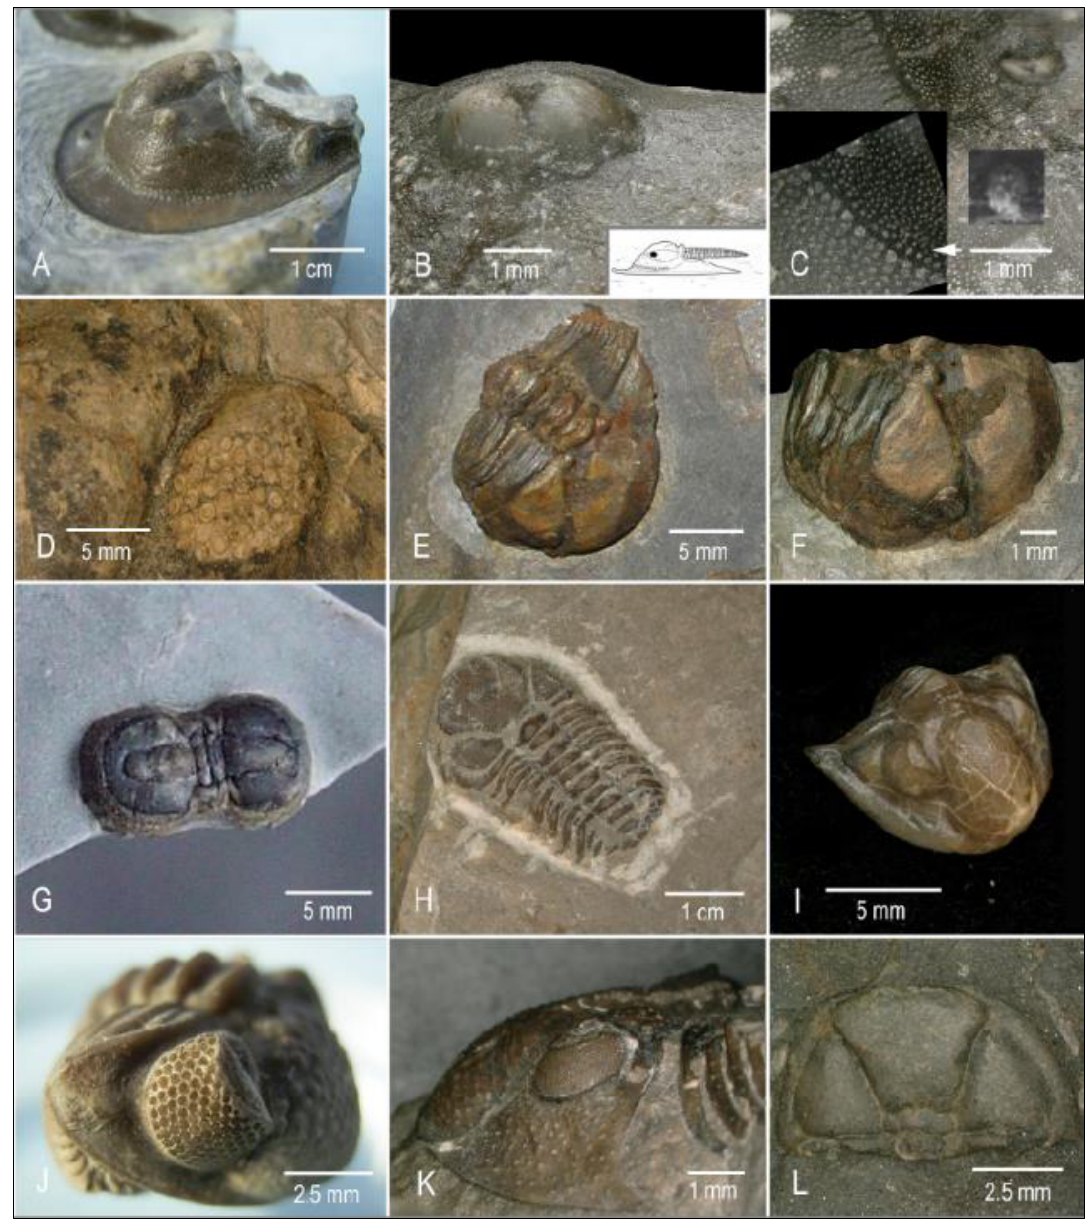
Figure 2. Trilobites blind, with reduced eyes or with well developed compound eyes. (A) Harpes macrocephalus (trilobite), Middle Devonian (Eifelium), Auberg/Gerolstein, Germany. (B) Reduced eye of a harpetid trilobite. Insert: Mode of life in harpetid trilobites. (C) Seam of the cephalon with numerous pores, interpreted as chemosensoric organs forming a “compound nose”. Small insert: pore. (D) Well developed schizochroal eye of Phacops (Omegops) accipitrinus, upper Devonian (late Famennian), Langenhorst/Velbert Germany. (E, F) Struveaspis cf. micromma, with reduced schizochroal eye, middle Devonian, Haiger, Germany. (G) Itagnostus interstrictus (Peronopsis interstricta), middle Cambrian, Wheeler Shale USA, perhaps a blind parasitic trilobite. (H) Trimerocephalus caecus, blind trilobite, Upper Devonian (Lower Famennian), Holy Cross Mountains, Poland. (I) Ditomopyge decurata, Permian, Kansas, USA, one of the last trilobites, but well equipped with big holochroal eyes. (J) Pedinopariops brongniarti, middle Devonian (Eifelium), Auberg/Gerolstein Germany, with typical schizochroal eye. (K) Scutellum flabelliferum, middle Devonian (Eifelium), Gees/Gerolstein, Germany, with typical holochroal eye. (L) Ductina ductifrons, blind trilobite, Upper Devonian (Famenne), Eskesberg/Wuppertal,